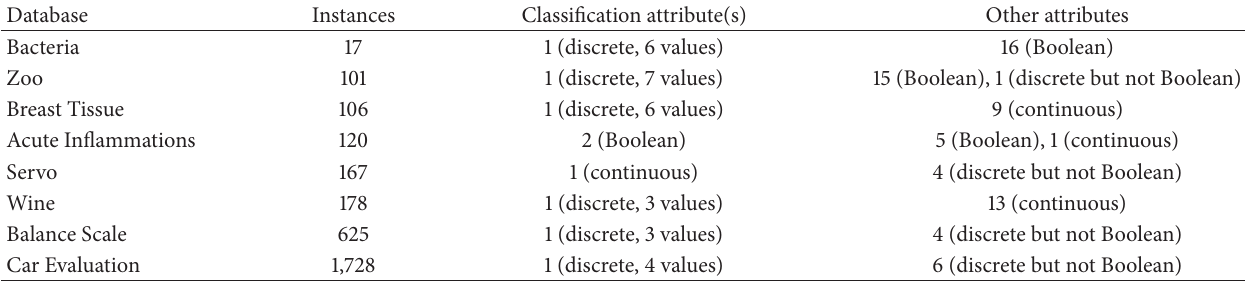
Table 2: The detailed information about the eight chosen databases in the experiments.